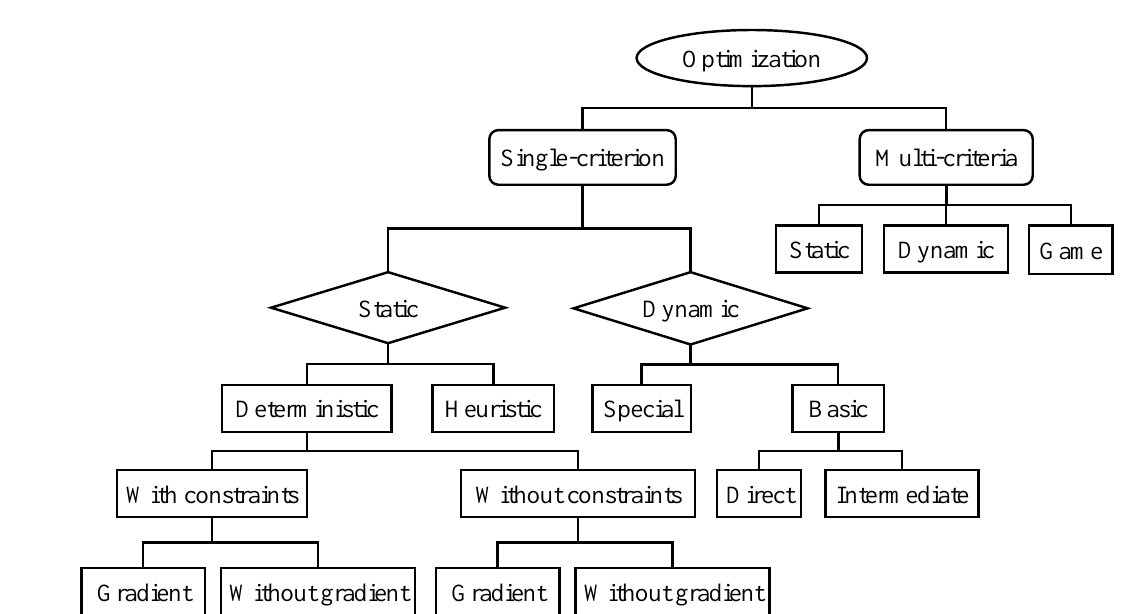
Figure 4. Categorization of optimization methods